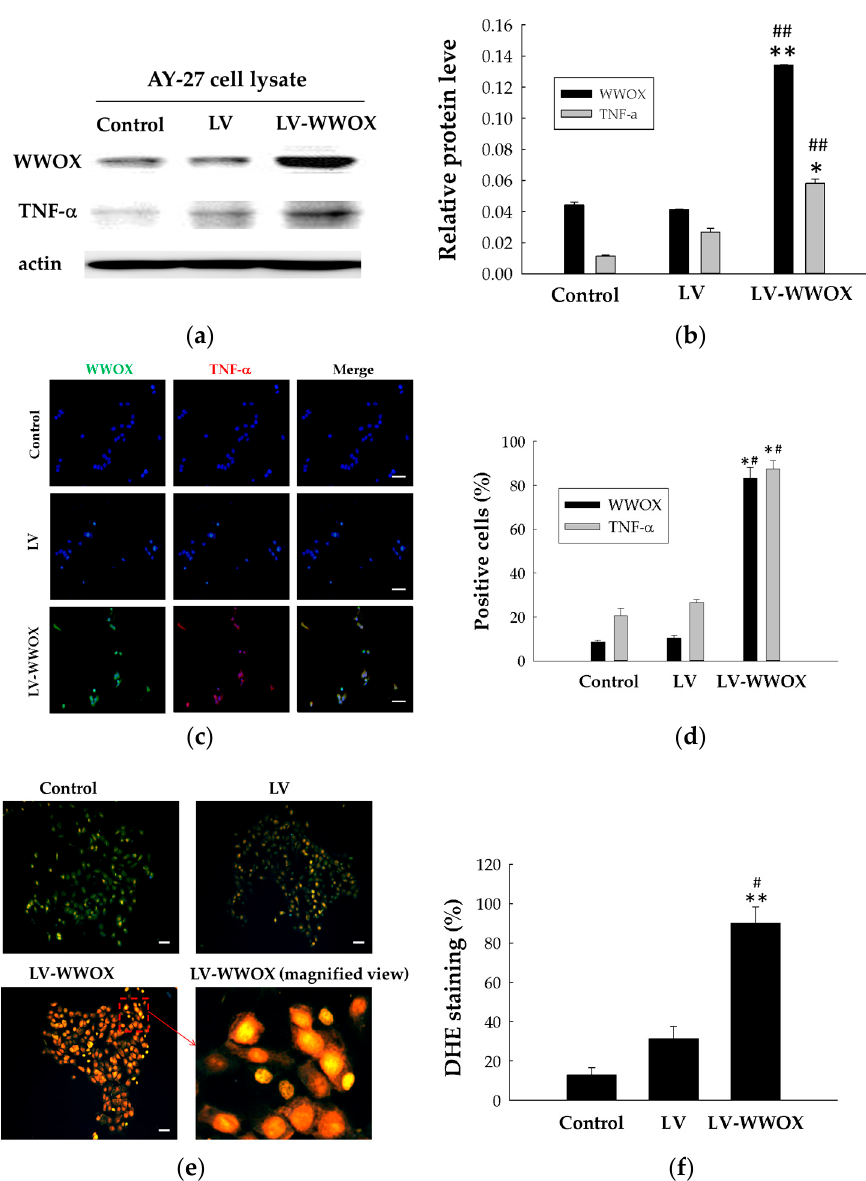
Figure 3. Overexpression of WWOX in AY-27 cells. WWOX-low AY-27 cells were infected with WWOX (LV-WWOX) or the negative control gene lentivirus (LV). ( a ) The expression of WWOX and TNF- α in LV-WWOX was detected by Western blot. Actin served as a loading control. ( b ) Protein expression was normalized to actin expression. The results are expressed as the mean ± SD. ( c ) The localization of WWOX and TNF- α in LV-WWOX was measured by immunofluorescence (×200). ( d ) The levels are expressed in positive cells (%). ( e ) Detection of ROS using DHE fluorescent dye in the AY-27, AY-27-LV, and AY-27-LV-WWOX cells (×200). ( f ) The levels are expressed in ROS-positive cells (%). The white bar in the right lower corner is 100 mm. Each bar represents the mean ± standard deviation (SD) from three independent experiments. The results are expressed as the means ± SDs. * p < 0.01 and ** p <0.001 compared to the control groups; # p < 0.01 and ## p < 0.01 compared to the LV groups. The white bar in the right lower corner is 100 mm.